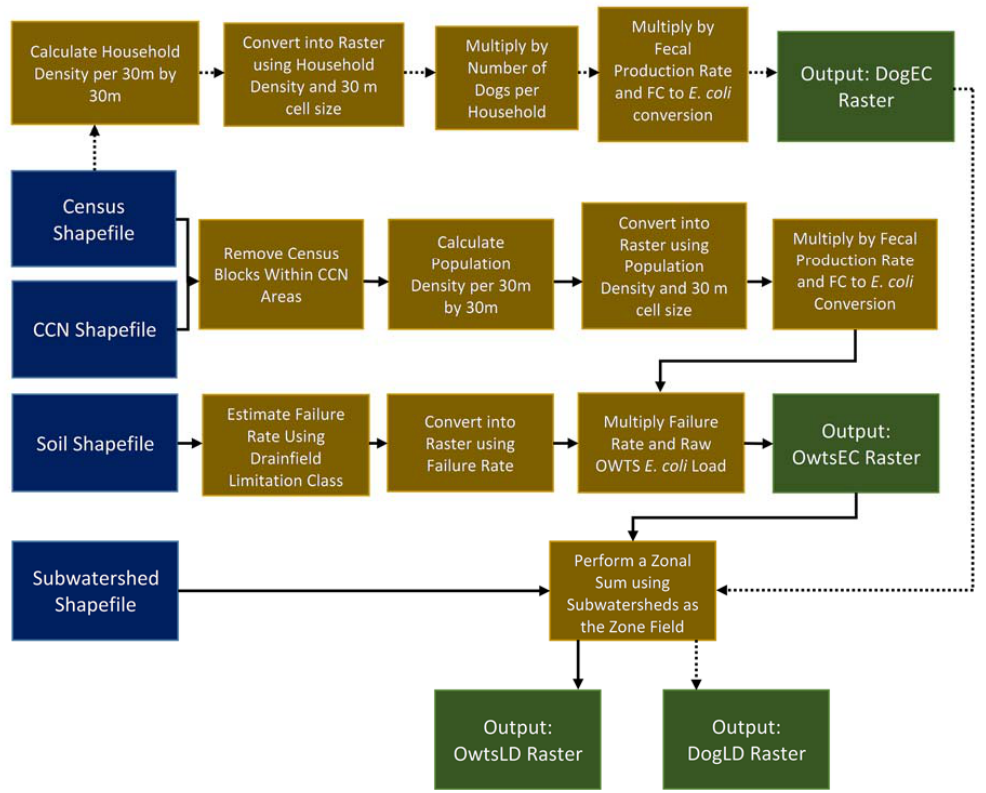
Figure 2. Calculation of potential E. coli loads, resulting from dogs (dashed line) and OWTS (solid line), in pySELECT.